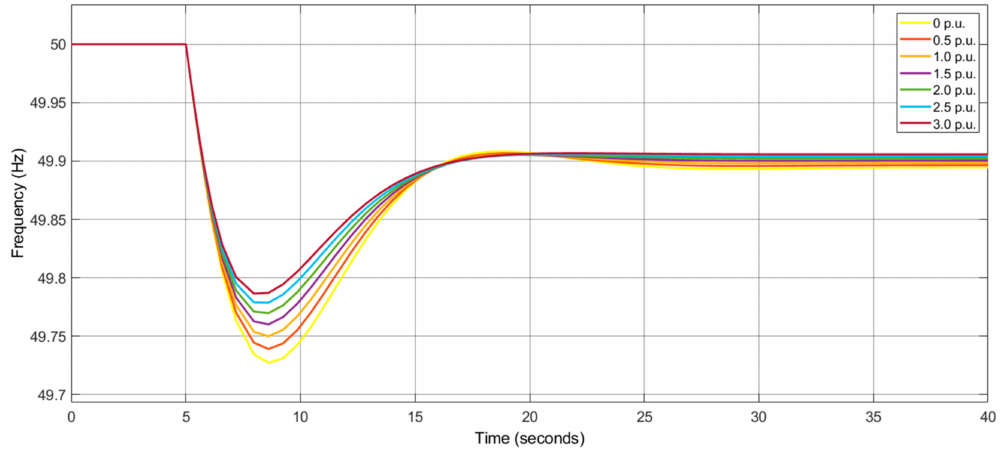
Figure 11. Impact of the load damping constant on the primary frequency